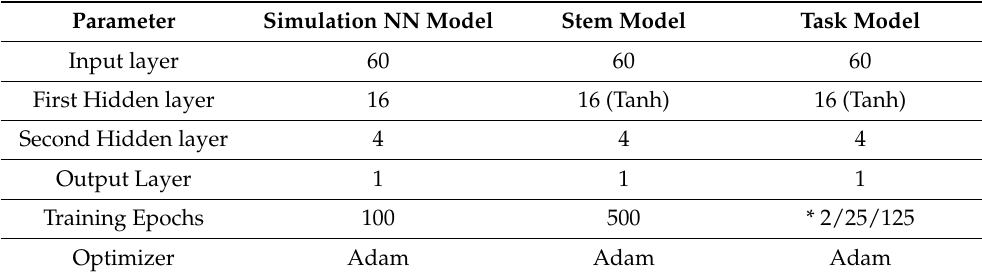
Table 1. DNN parameters for three types of models used in the experiment.